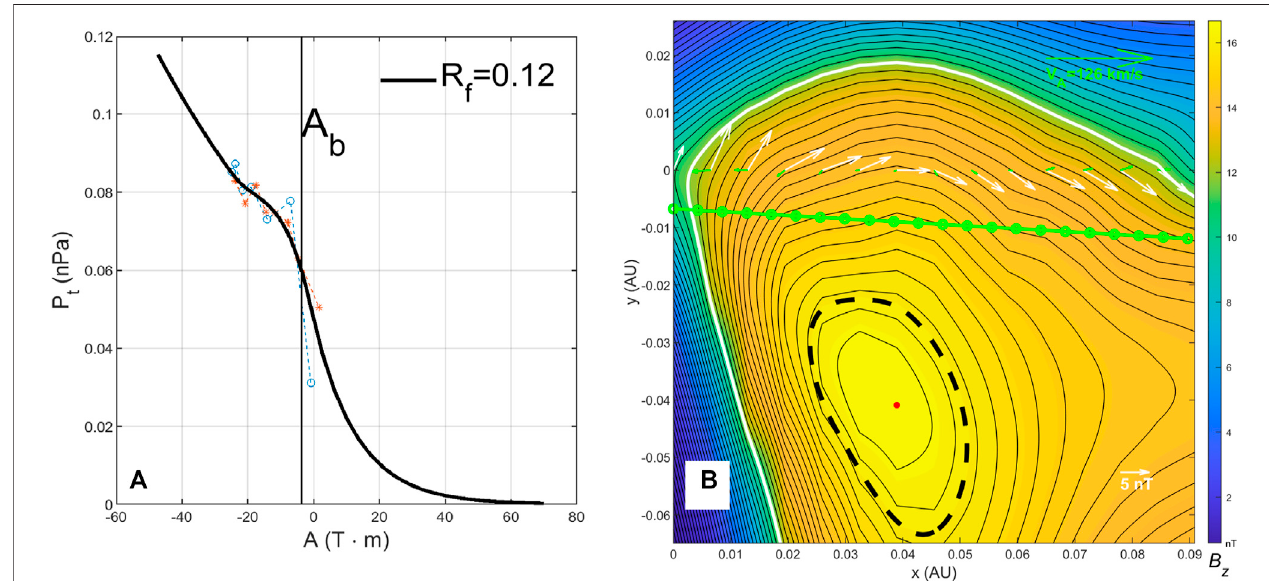
FIGURE 2 | (A) The P t versus A data (symbols) along the Wind spacecraft path, and the fi tted P t ( A ) curve (thick black curve) with the corresponding fi tting residue R f denoted. The vertical line marks the boundary de fi ned by A (cid:2) A b , (B) The cross section map from the GS reconstruction for the MC interval marked in Figure 1 . The black contours are the iso-surfaces of A ( x , y ) , and the fi lled color contours indicate the axial fi eld B z ( A ) with scales given by the colorbar. The Wind spacecraft path is projected along y (cid:2) 0 with white (green) arrows representing the measured transverse magnetic fi eld (remaining fl ow) vectors. A reference vector proportional in magnitude for each set is provided, respectively, with the white reference vector in the lower right of magnitude 5 nT and the green reference vector of the magnitude of the average Alfvén speed in the top right. The SO spacecraft path is projected onto the same map as the green line with green circles. The thick dashed contour line highlights the outermost closed loop surrounding the center marked by the red dot where B z reaches the maximum B z 0